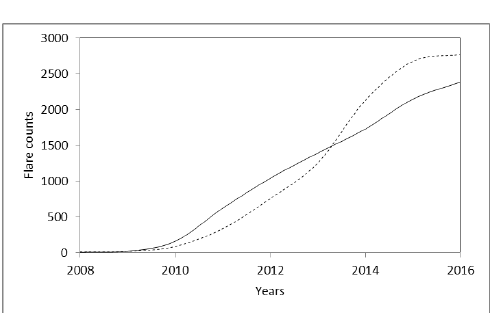
Figure 3. Cumulative counts of flares occurring in northern (solid line) and southern (dashed line)